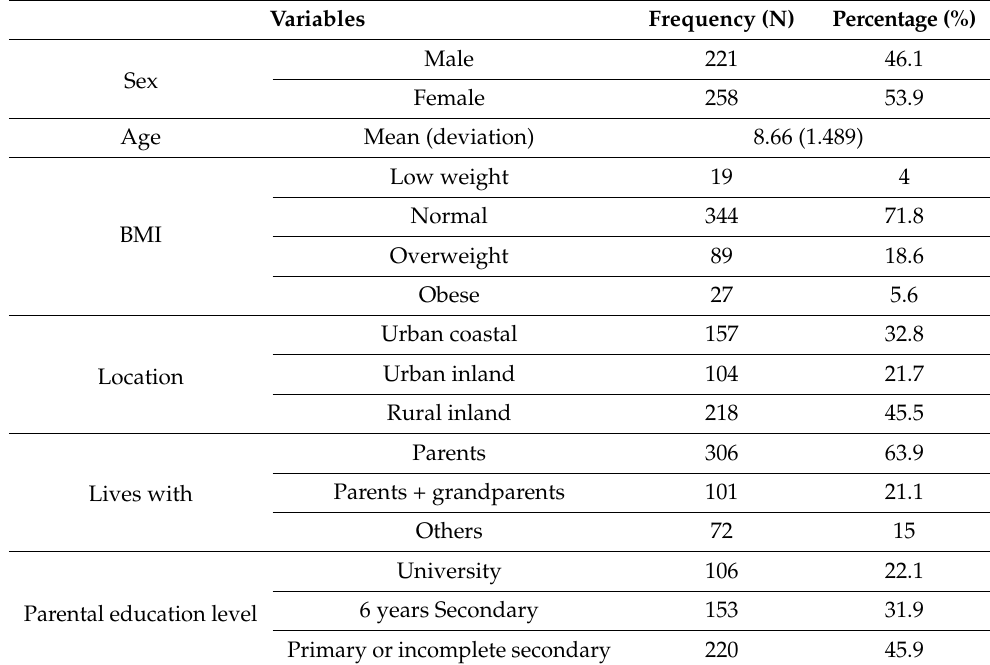
Table 1. Descriptive analysis of sample.